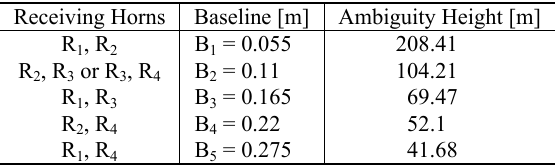
Table 2. Available baselines and corresponding typical